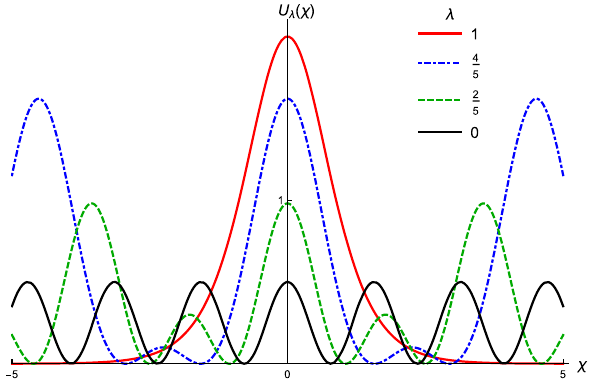
Fig. 2 The solution χ L ,λ for some values of λ and θ 2 = 1 − λ . Here we observe how the large kink of the model evolves from the sine Gordon kink to the vacuumless solution